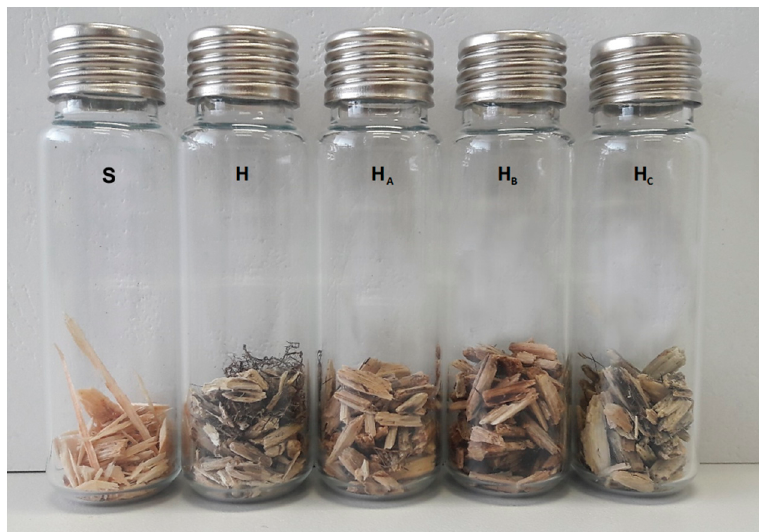
Figure 1. The samples closed in vials ready for GC-MS analysis—visual color change: (S—spruce strands, H—untreated hemp shive, H A —hemp shive after tartaric acid treatment, H B —hemp shive after citric acid treatment, H C —hemp shive after sodium bicarbonate treatment).